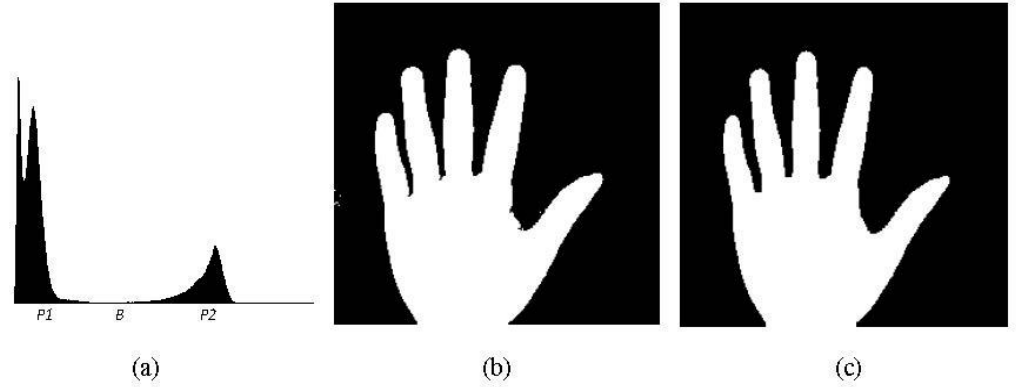
Figure 3. ( a ) Histogram of the palm image from Figure 2a1. The vertical and horizontal axes represent pixel numbers and grey values, respectively. P1 and P2 are gray values with the local maximum pixel numbers, whereas B is the gray value with the local minimum pixel number. B is selected as the threshold to segment the palm region; ( b ) Binarized image of the palm region segmented using threshold B , which was selected by the mode method; ( c ) Resulting image of the binary palm image from ( b ) after processing by dilation (twice) and erosion (twice).